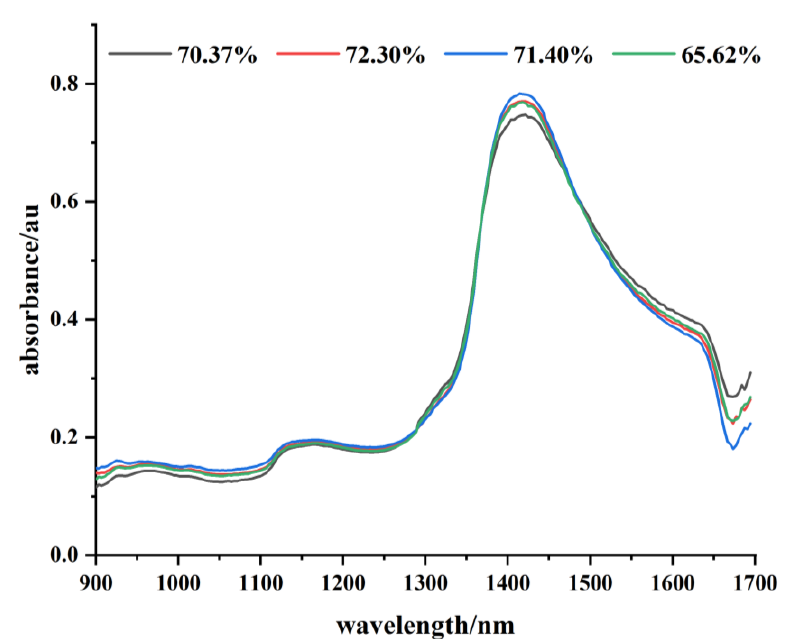
Figure 3. Spectral images of tea leaves with different water contents.